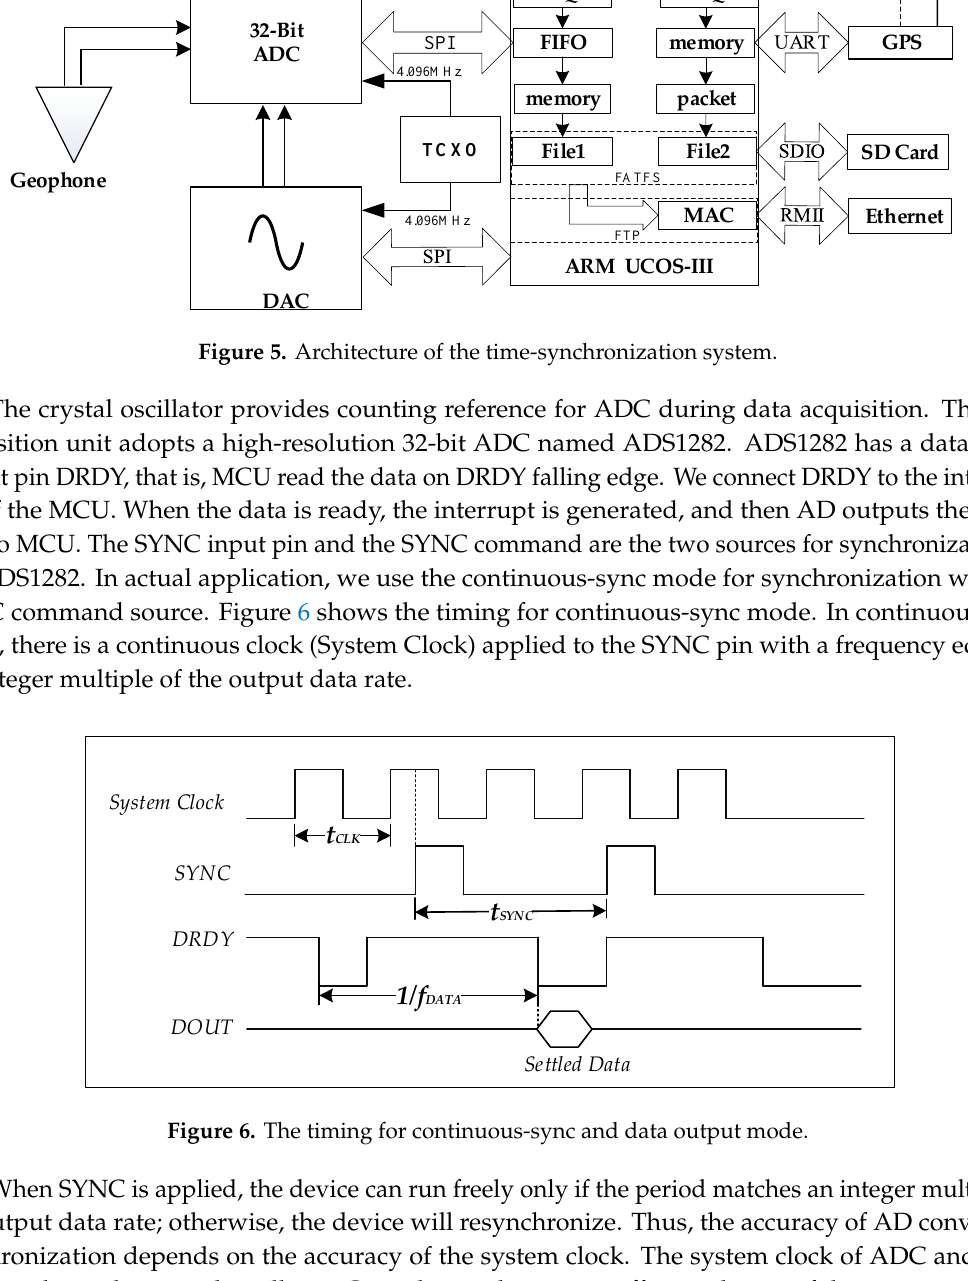
Table 1. Main indicators of the crystal oscillator.